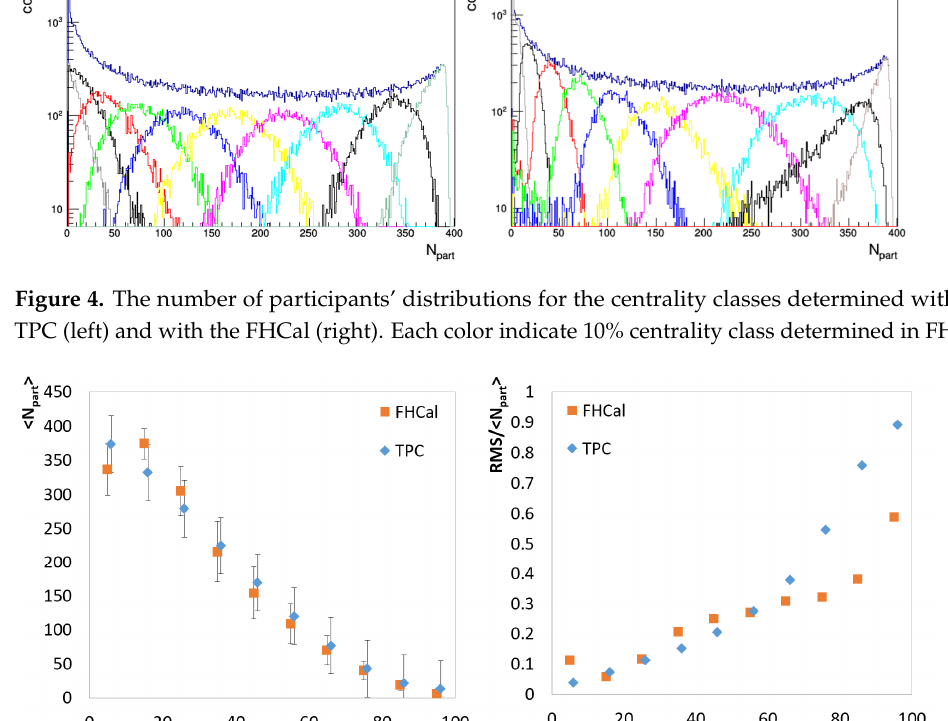
Figure 4. The number of participants’ distributions for the centrality classes determined with the TPC (left) and with the FHCal (right).